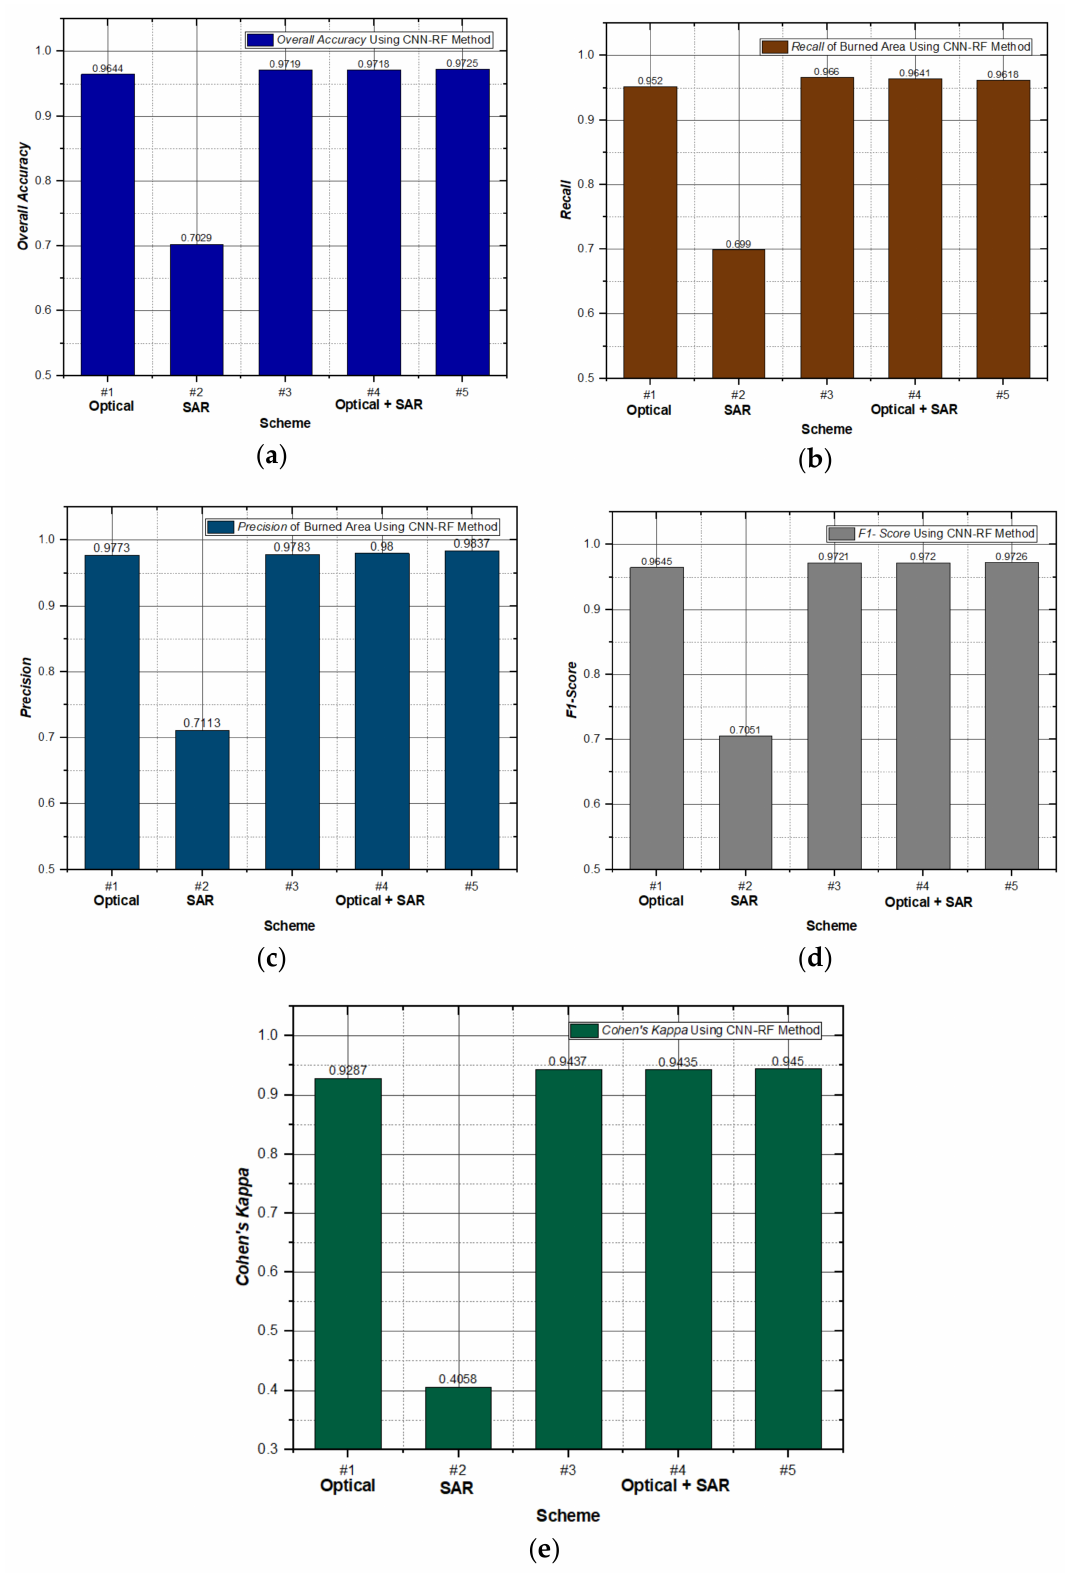
Figure 11. Performance of burned area classification model using CNN-RF method for Schemes #1–#5 with evaluation parameters ( a ) OA; ( b ) recalls; ( c ) precision; F1-score; and ( d ) Cohen’s